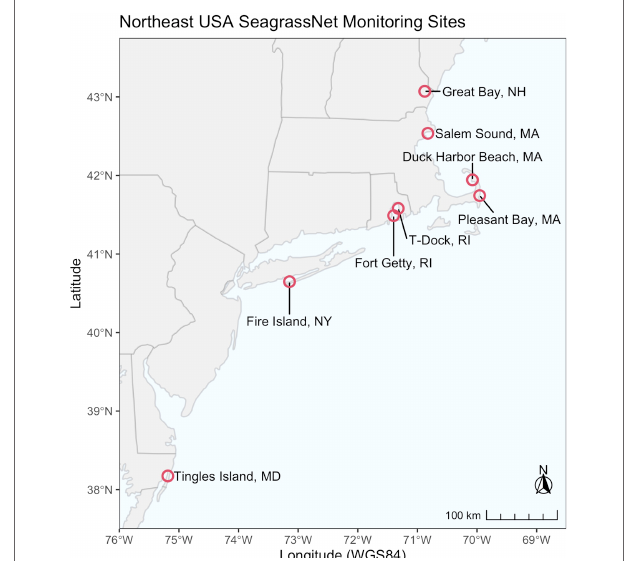
FIGURE 1 | SeagrassNet sites located in Northeast